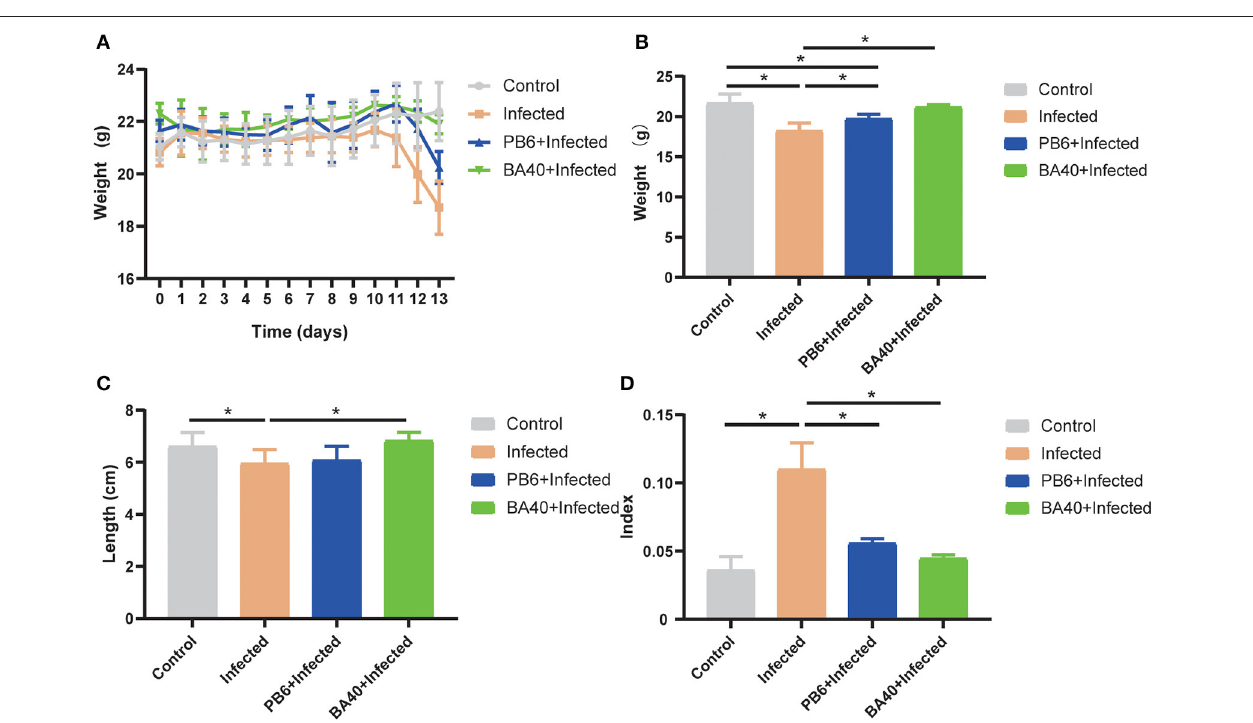
FIGURE 2 | Effect of Bacillus amyloliquefaciens 40 (BA40) administration on the growth performance of mice. (A) Bodyweight (BW) was weighted among four groups. (B) At the end of the experiment, each group was weighted and expressed as mean ± SD. (C) The colon length among the four groups. (D) The spleen index of the four groups. (*represented significant differences, P <